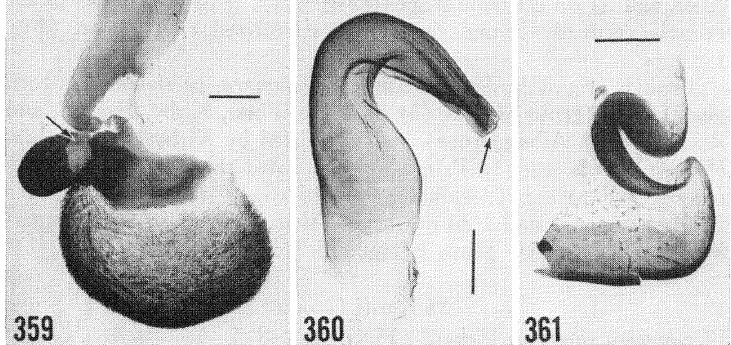
Figs. 359-361. (108 MCZ). Cockroach male genitalia of Epilampra ex- ploratrix (Gurney). Holotype 25559 of ludreia exploratrix Gurney. Buenos Aires, Trinidad Mts., Santa Clara Province, Cuba. (the left side of L2d [-Fig. 359, arrow] was torn due to pressure of the coverslip, and the tip of R2 [Fig. 360, arrow] was accidentally cut off). (scale 0.2